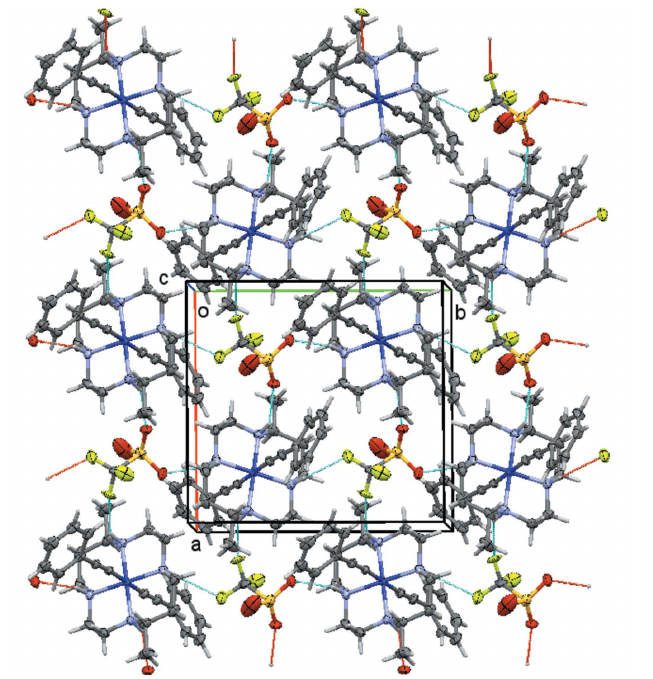
Figure 9 Hydrogen-bonding interactions in 2 , showing the hydrogen-bonded layer formed by cations and anions of Co1 and S1, respectively. Hydrogen bonds are depicted as dashed turquoise lines. View is slightly tilted down the c axis. Disorder of the trifluoromethanesulfonate anion is omitted for clarity. Figure 10